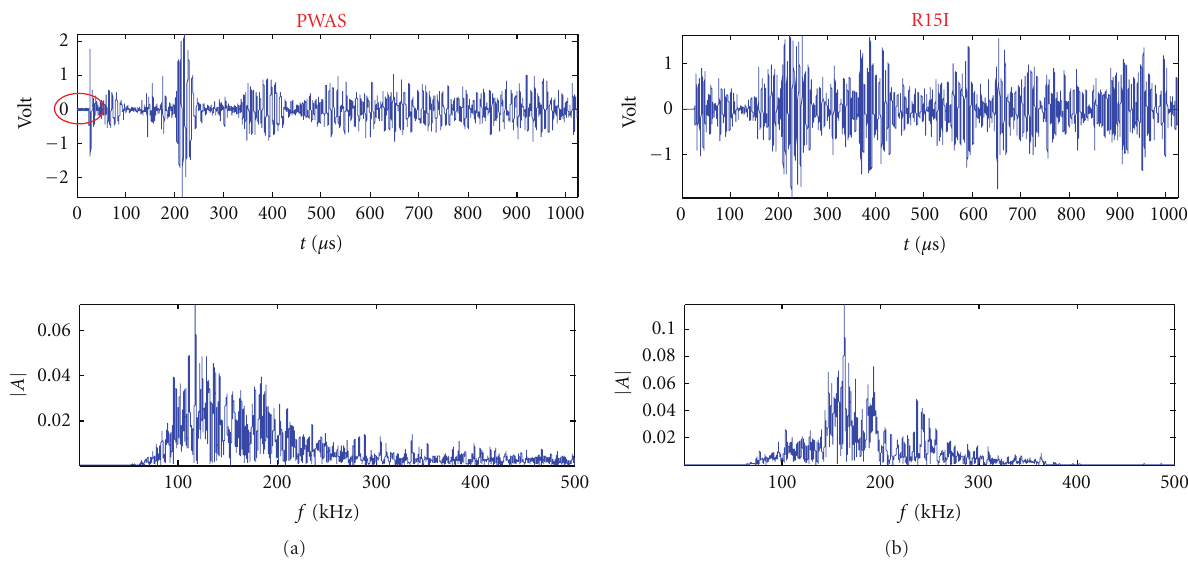
Figure 4: 0.5mm PLB detection on 1.6-mm aluminum plate. (a) PWAS AE waveform and its frequency spectrum; (a) R15I AE waveform and its frequency spectrum.